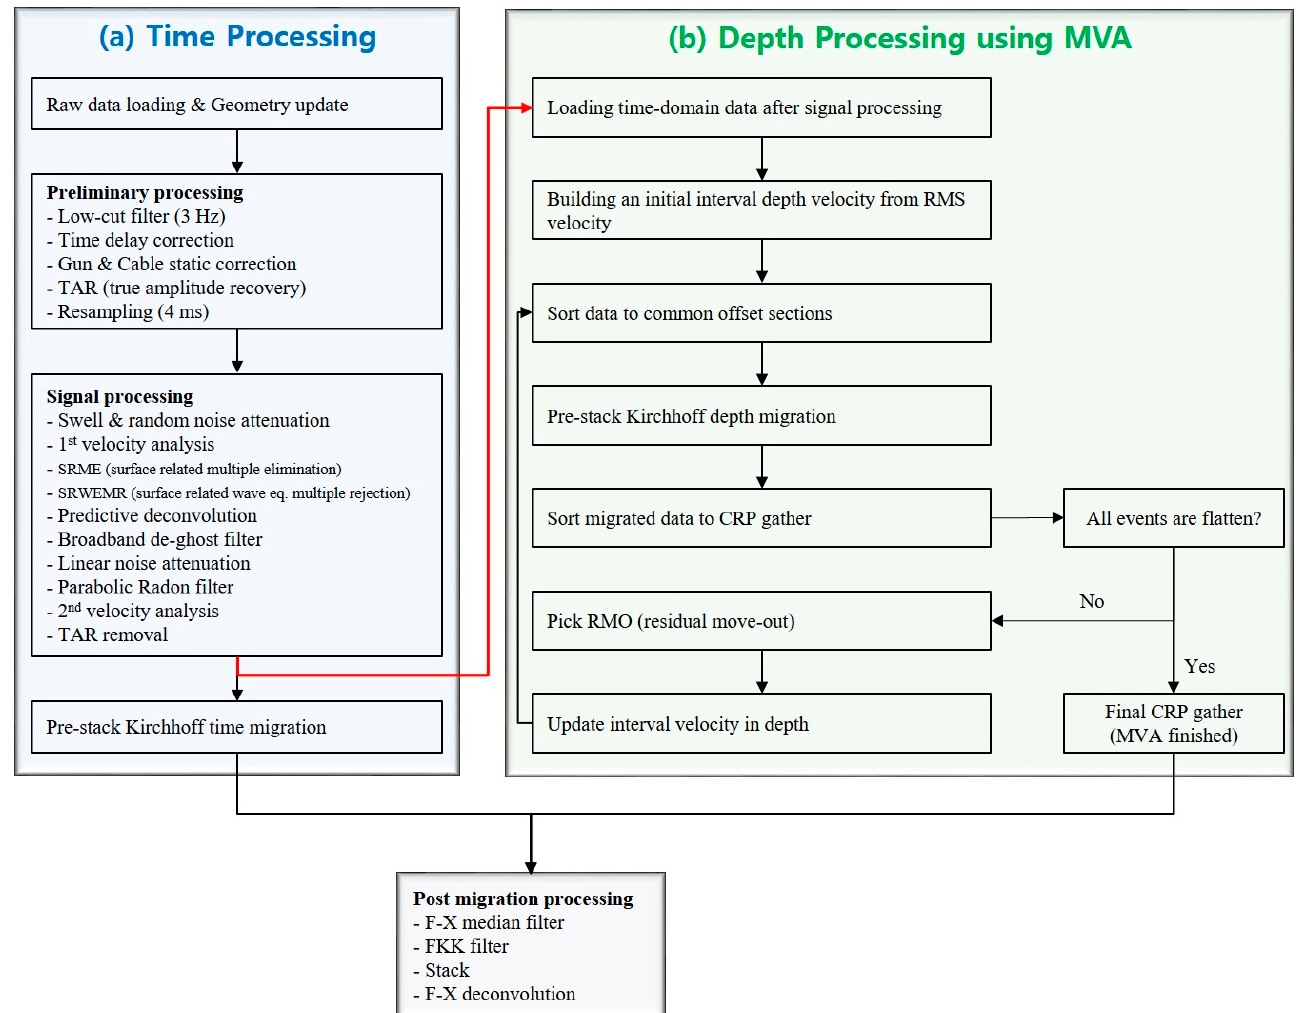
Figure 3. Seismic data processing workflows in the ( a ) time and ( b ) depth domains.